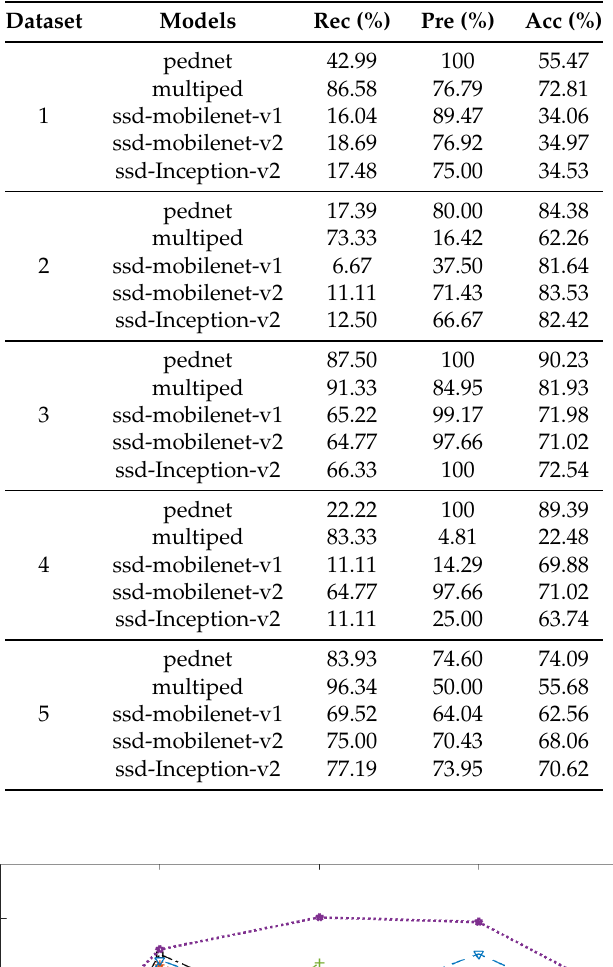
Table 2. Pedestrian detection result.